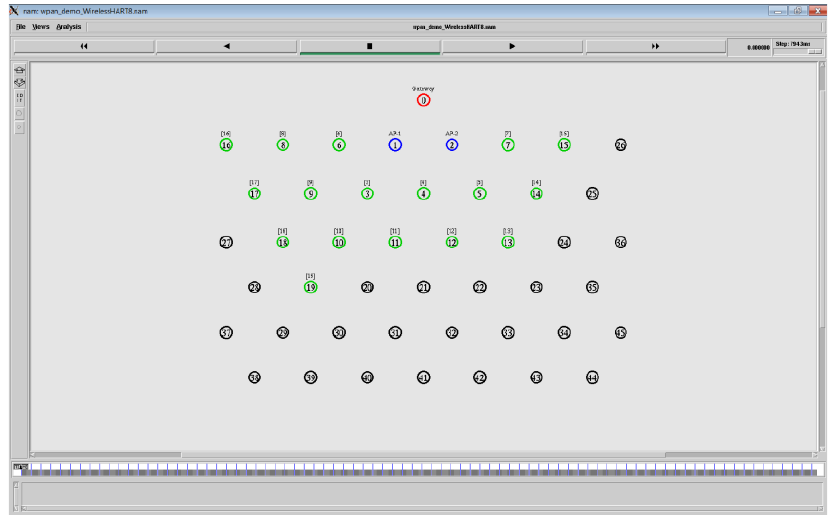
Figure 18. The network topology from animation tool of NS-2 simulator (nam).